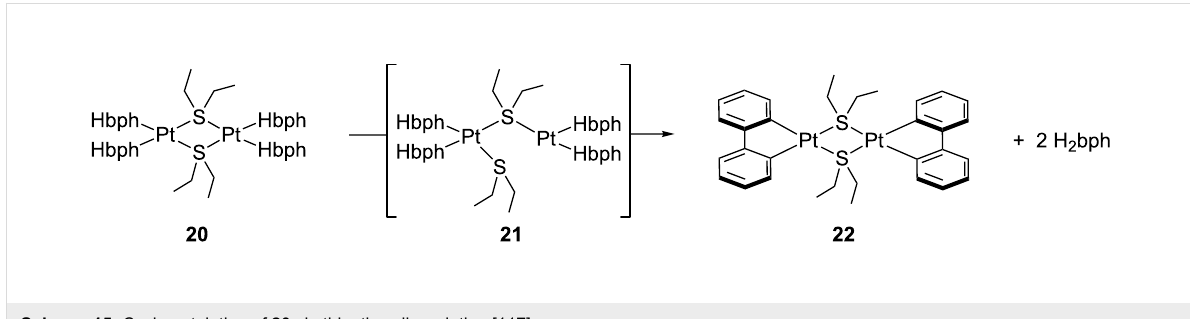
Scheme 15: Cyclometalation of 20 via thioether dissociation